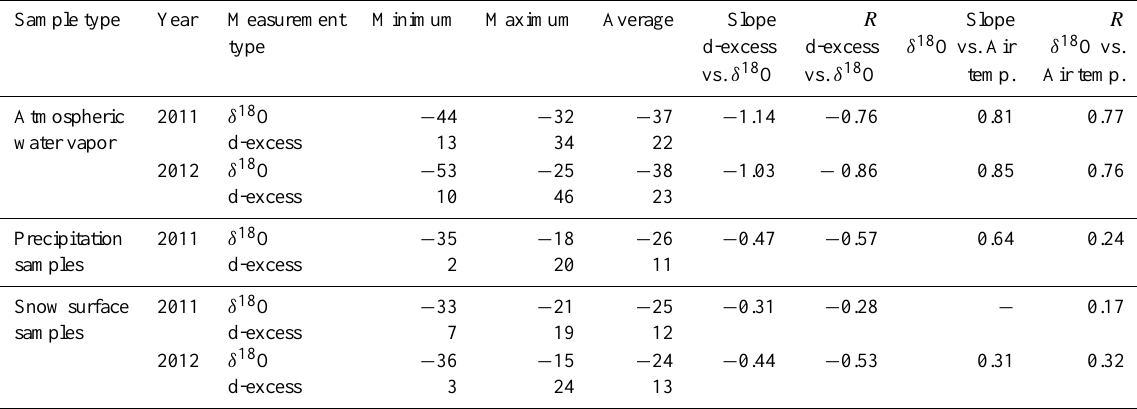
Table 2. Overview of the distribution of the observed δ 18 O and d-excess together with the slope and correlation for d-excess vs. δ 18 O and δ 18 O vs. air temperature for the atmospheric water vapor, precipitation samples, and snow surface